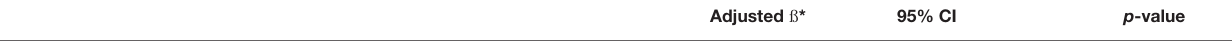
TABLE 3 | Multivariable model exploring associations between gender identity, gender and number of severe adverse